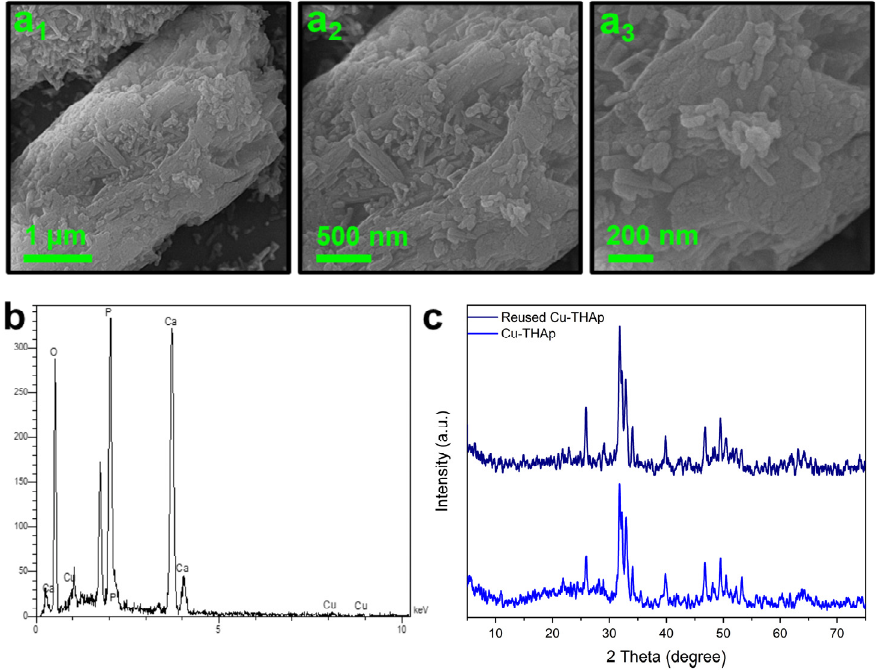
Figure 5. ( a1 – a3 ) SEM images, ( b ) EDS spectra, and ( c ) XRD pattern of reused Cu-THAp.